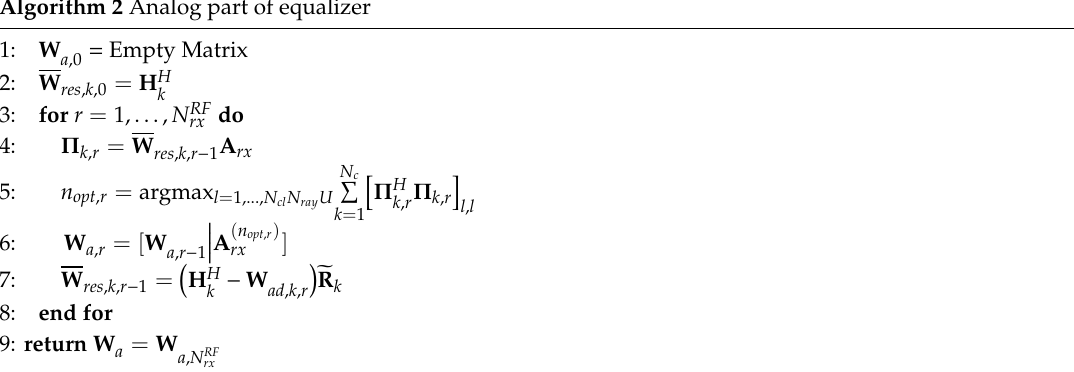
Algorithm 2 Analog part of